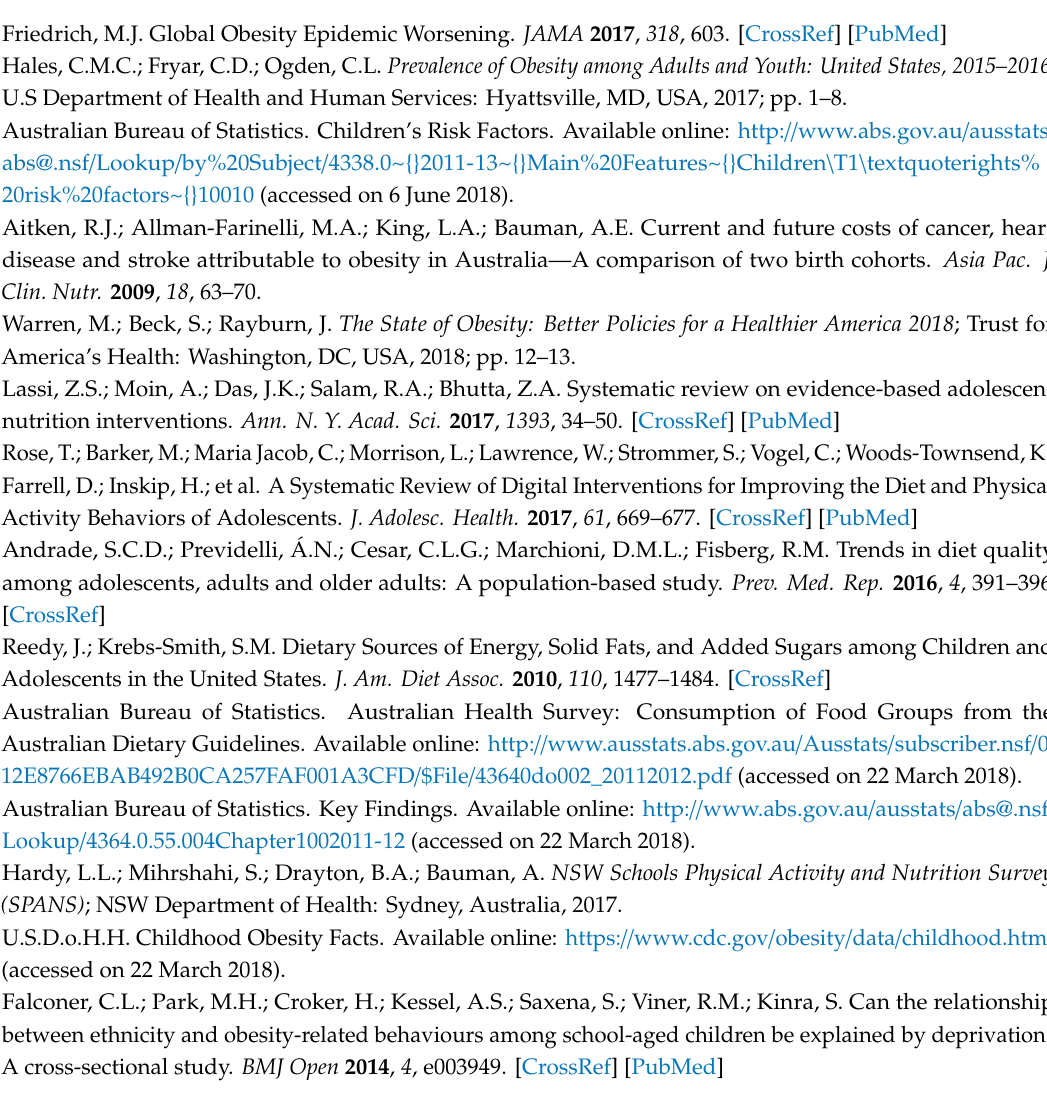
Table S1: Search Strategy Medline (Search 1), Table S2: Full-Text Articles excluded and supported reasoning, Table S3: A Risk of bias as assessed by the Cochrane Collaboration Tool 32 for the randomized controlled trials included in the systematic review of e ff ectiveness of preventions interventions for adolescents from ethnic / racial minorities ( n = 7), Table S4: Risk of bias as assessed by the Cochrane Collaboration Tool 32 for the randomized controlled trials included in the systematic review of e ff ectiveness of preventions interventions for adolescents from ethnic / racial minorities ( n =